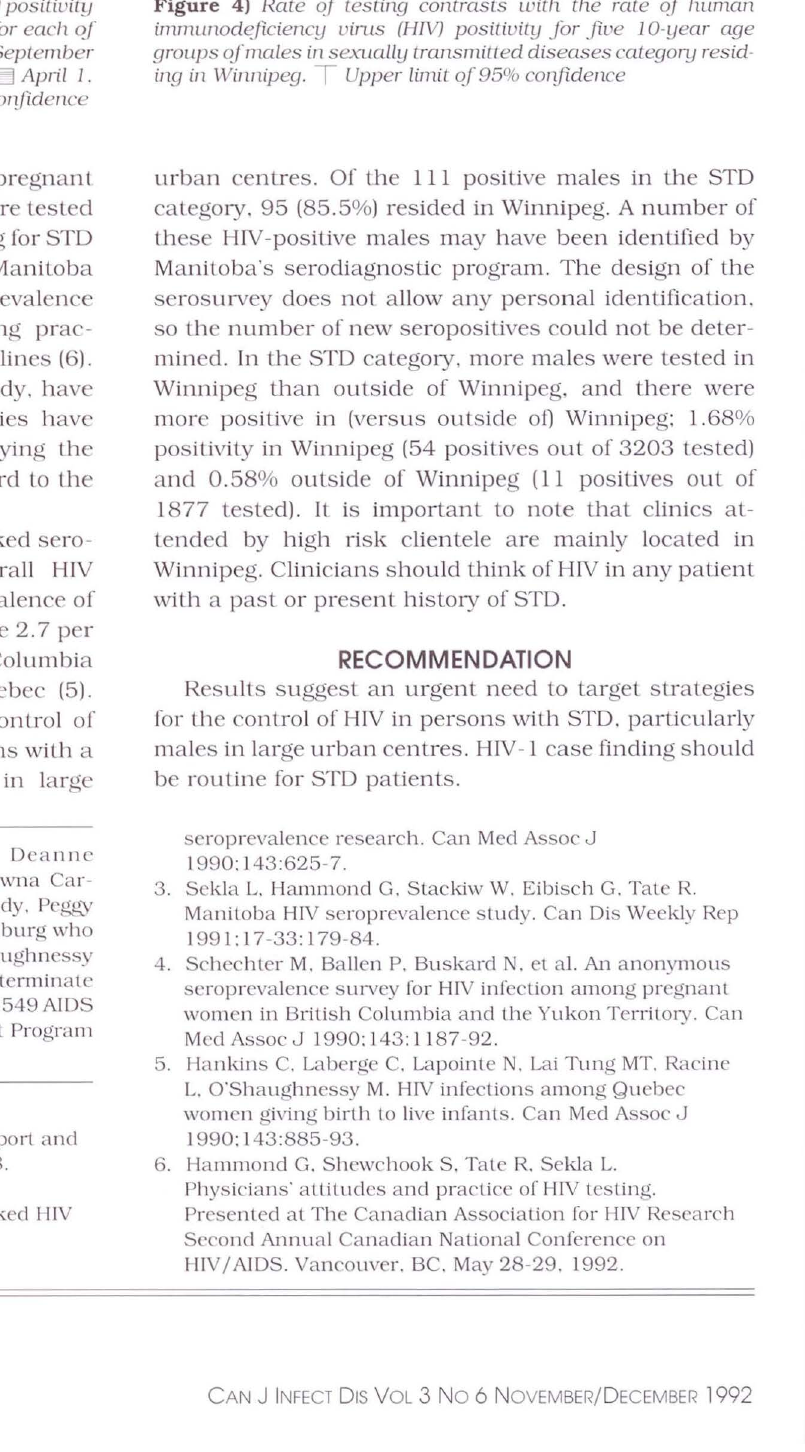
Figure 4) Rate of testing contrasts with the rate q{ human immw10df!ficiency virus (HTV] positivity for jive 10-year age groups oJmales in sexually transmilied diseases category resid ing in Winnipeg. T Upper limit of 95% conjidence